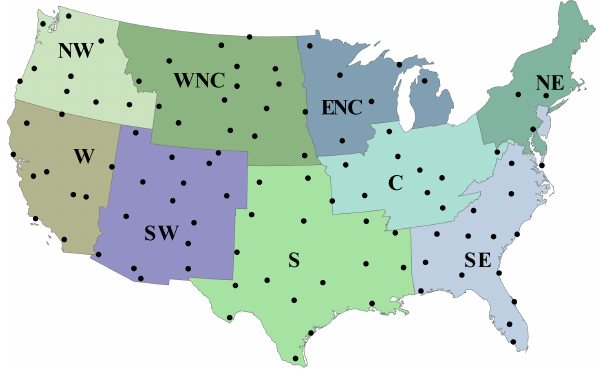
Figure 1. US climate regions: NW (Northwest), WNC (West north central), ENC (East north central), NE (Northeast), C (Central), SE (Southeast), S (South), SW (Southwest), and W (West). The circles represent the sampled USCRN stations in the